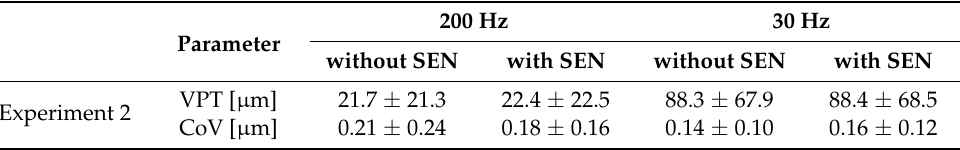
Table 2. Mean ± SD VPT and CoV, differentiated according to the measurement condition at 200 Hz and 30 Hz.